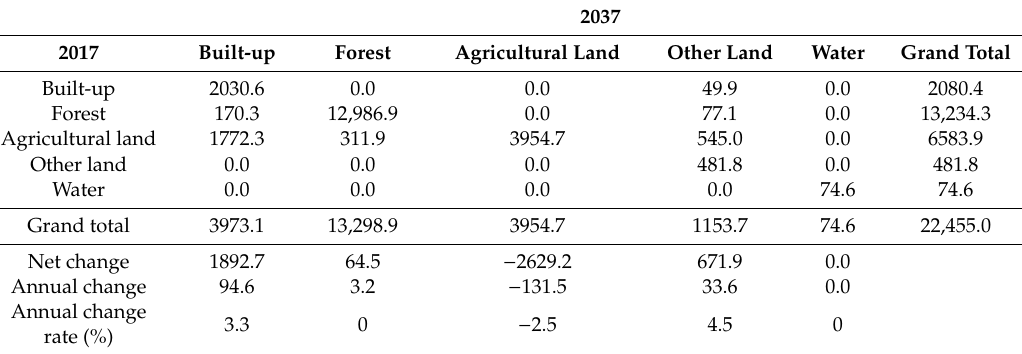
Table 11. Land use and land cover change matrix (ha),